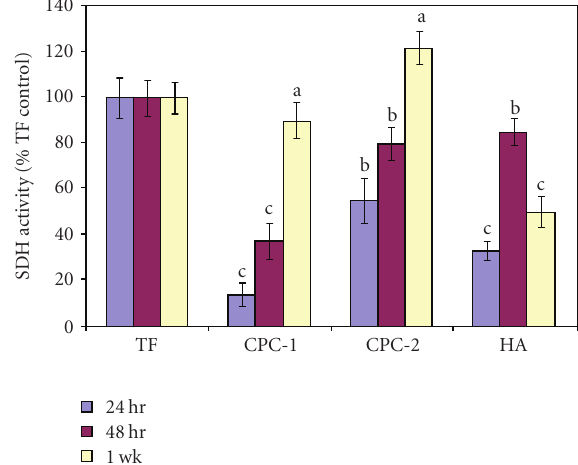
Figure 3: Histogram showing the mean diametral strength of hydroxyapatite cement and the two polymeric CPCs inMPa Figure 4: Mitochondrial suppression induced by CPC-1, CPC-2, and commercial HA. Cytotoxicity was evaluated at three time points 24hrs, 48hrs and after 1wk. Succinic dehydrogenase activity was measured and expressed as a percentage of Teflon Controls (defined as 100%). There were six replicates per condition. Di ff erent letters indicate a statistically significant di ff erence between the materials (ANOVA, Tukey intervals α = 0 .